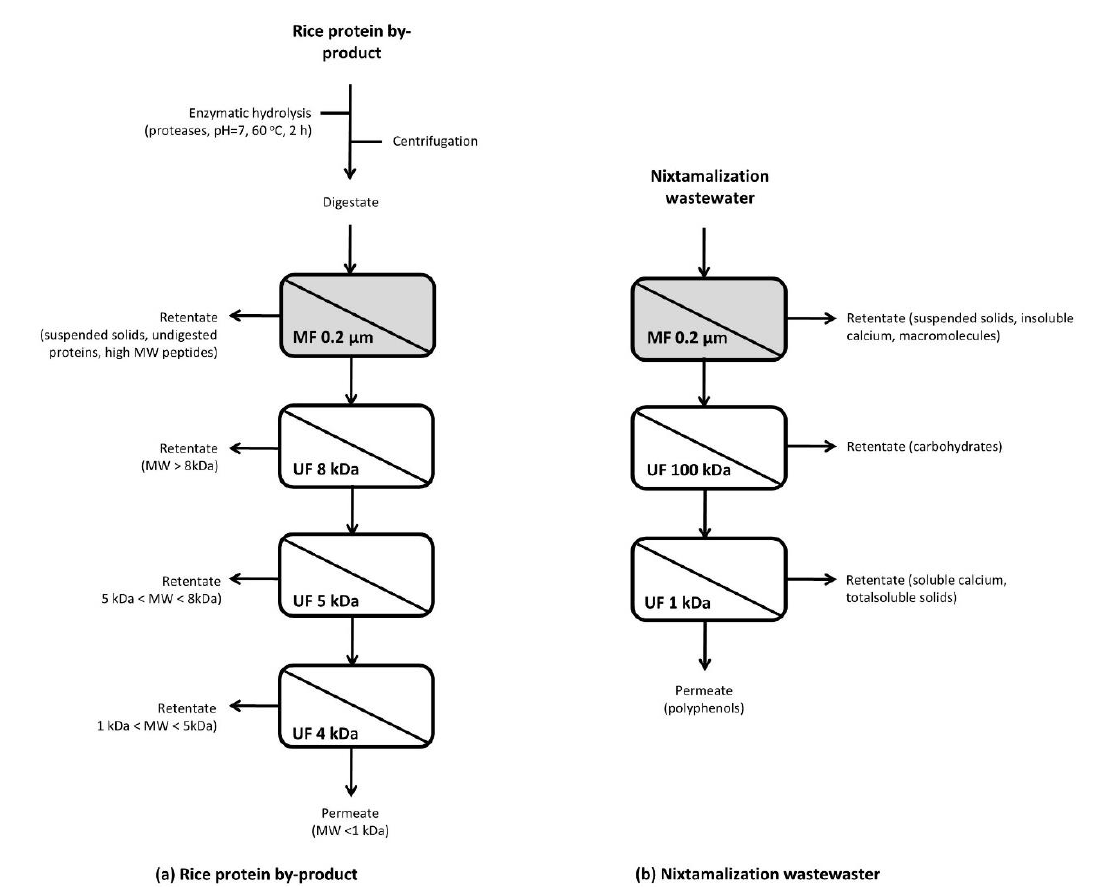
Figure 1. Process flow for the recovery of valuable compounds from ( a ) rice protein by-product and ( b ) nixtamalization wastewater using integrated membrane processes. MF: microfiltration, UF: ultrafiltration, MW: Molecular weight. Remade from [16,30,65].